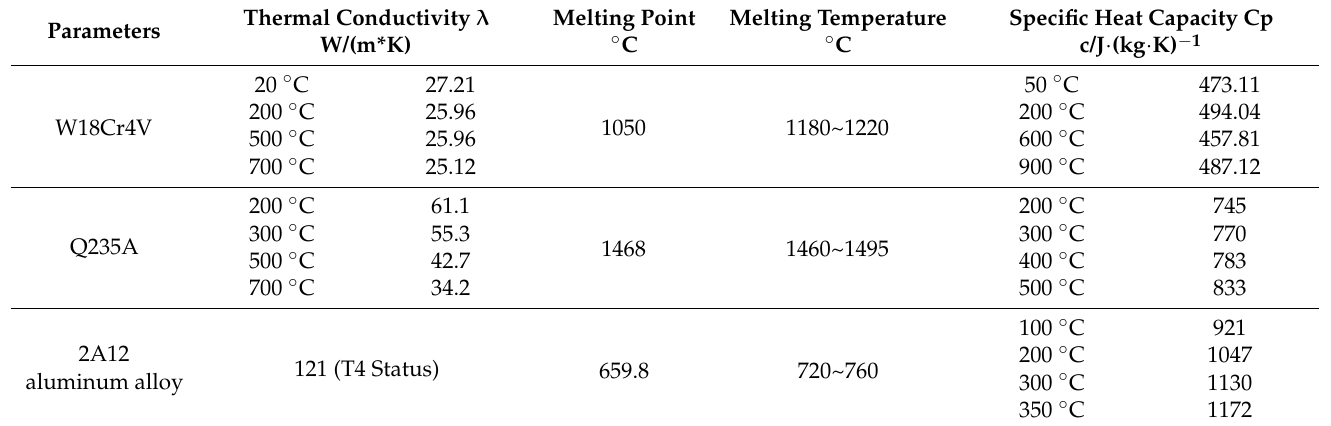
Table 1. Material properties.